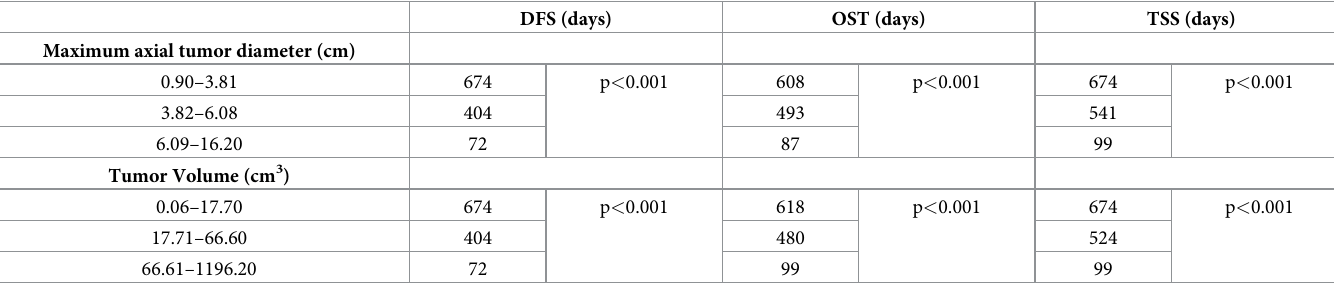
Table 7. Outcome parameters for dogs with lung adenocarcinoma based on tumor diameter and volume. DFS (days) OST (days) TSS (days) Maximum axial tumor diameter